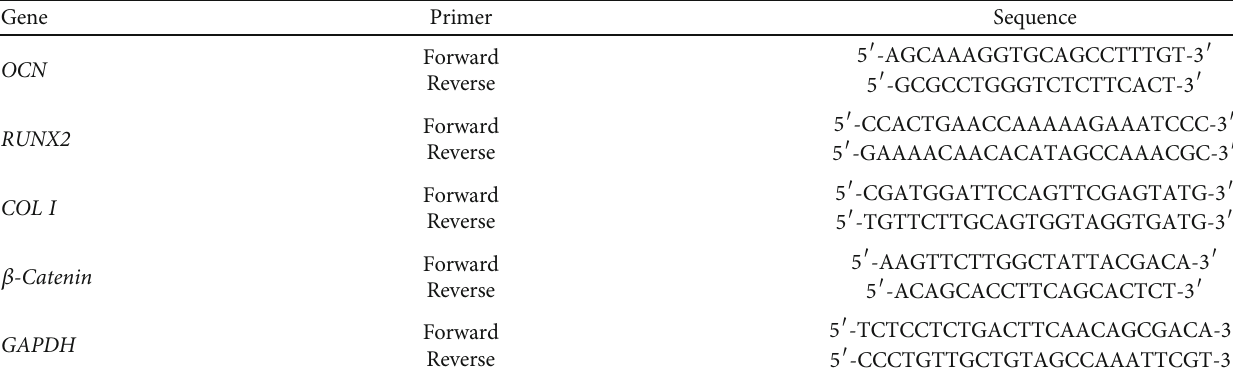
Table 1: Primer sequences used in